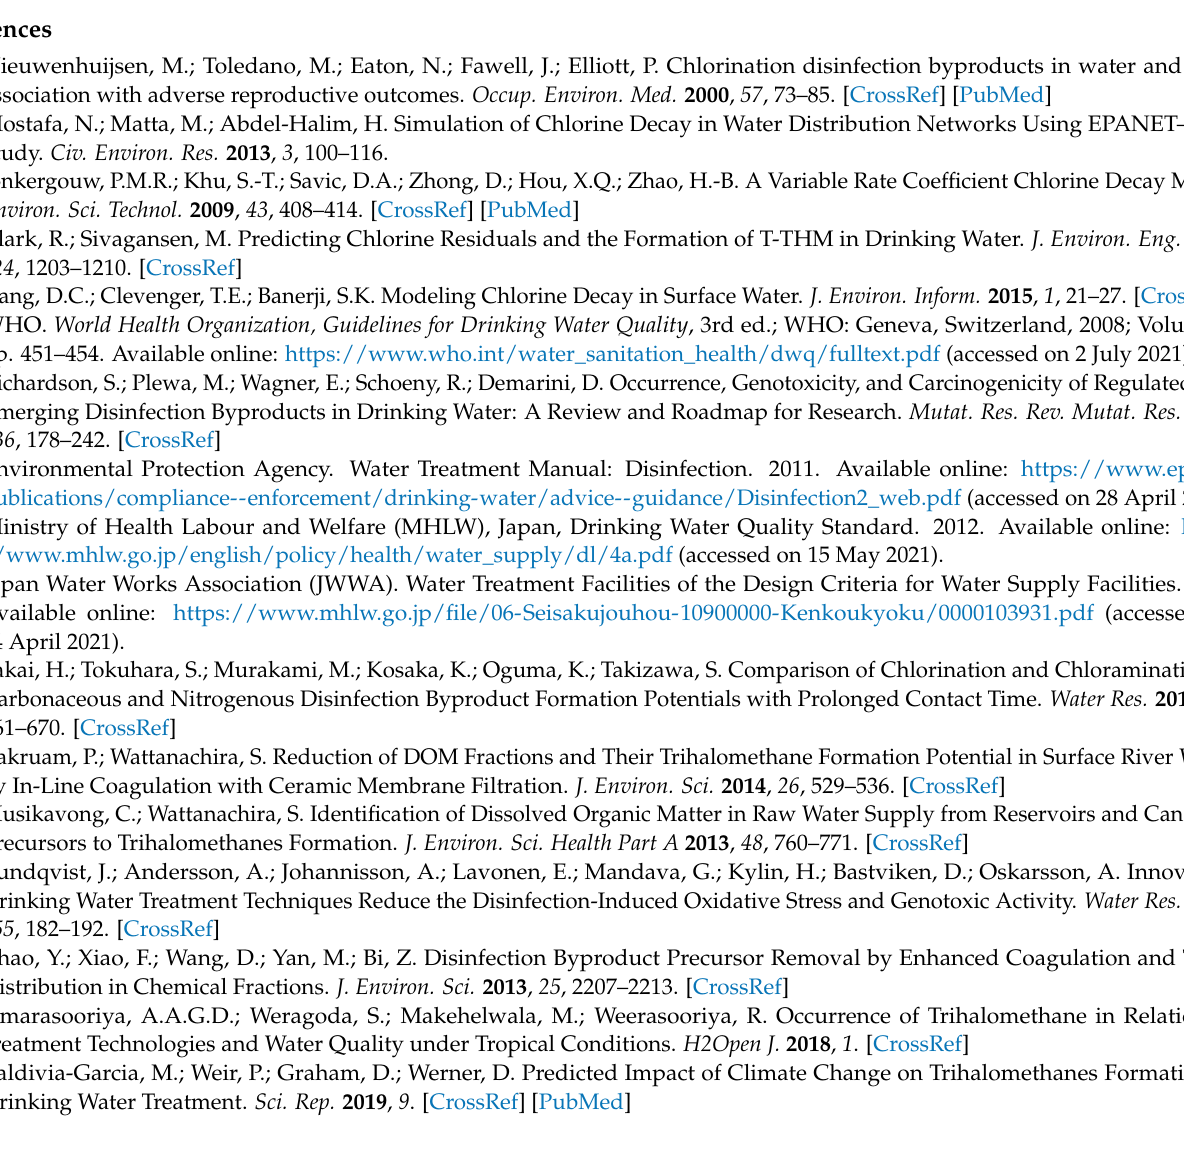
Figure A6. Simulation of trihalomethanes in Phase 2: ( a ) T-THM model; ( b ) T-THM in N-OKP area; ( c ) T-THM concentration with initial T-THM for treated water: 85 µg/L; ( d ) T-THM concentration in model after halting pre-chlorination: 60 µg/L.